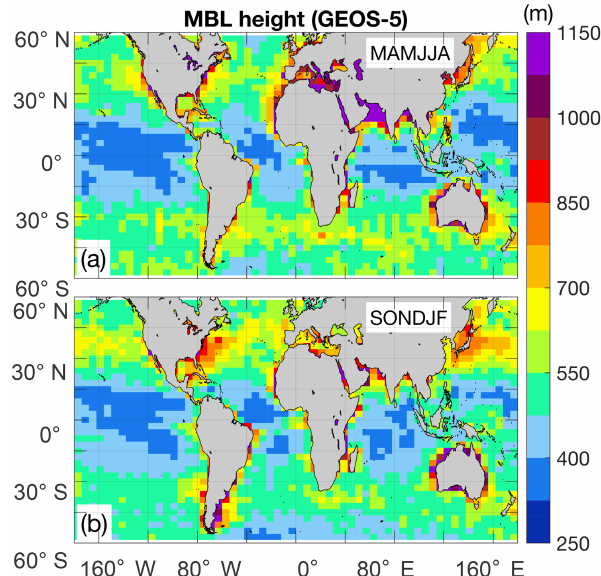
Figure 12. Daytime marine boundary layer height for (a) spring– summer and (b)